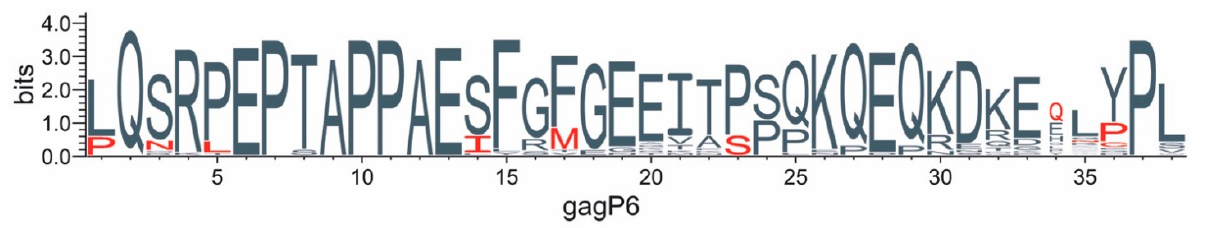
Figure 6. Protein changes in Gag-P6 region. The amino acid sequence of the Gag-P6 domains from the 32 sequences were aligned and a sequence logo was generated using Weblogo3 [39]. Amino acids are indicated by a single letter code with the height of each letter stack indicating conservation at that position (measured in entropy bits, see [39]) and the height of the letter within the stack indicating the relative frequency of the amino acid at that position. Amino acids found only in the genomes with VRC ≤ 0.4 are indicated in red.